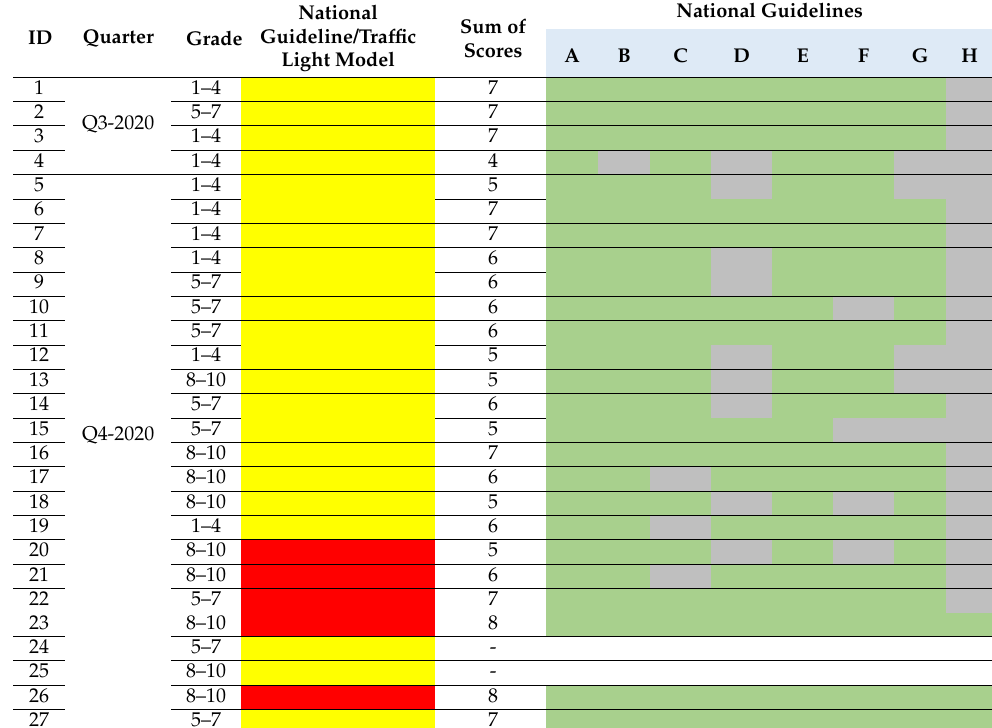
Table A3. Infection Prevention and Control (IPC)